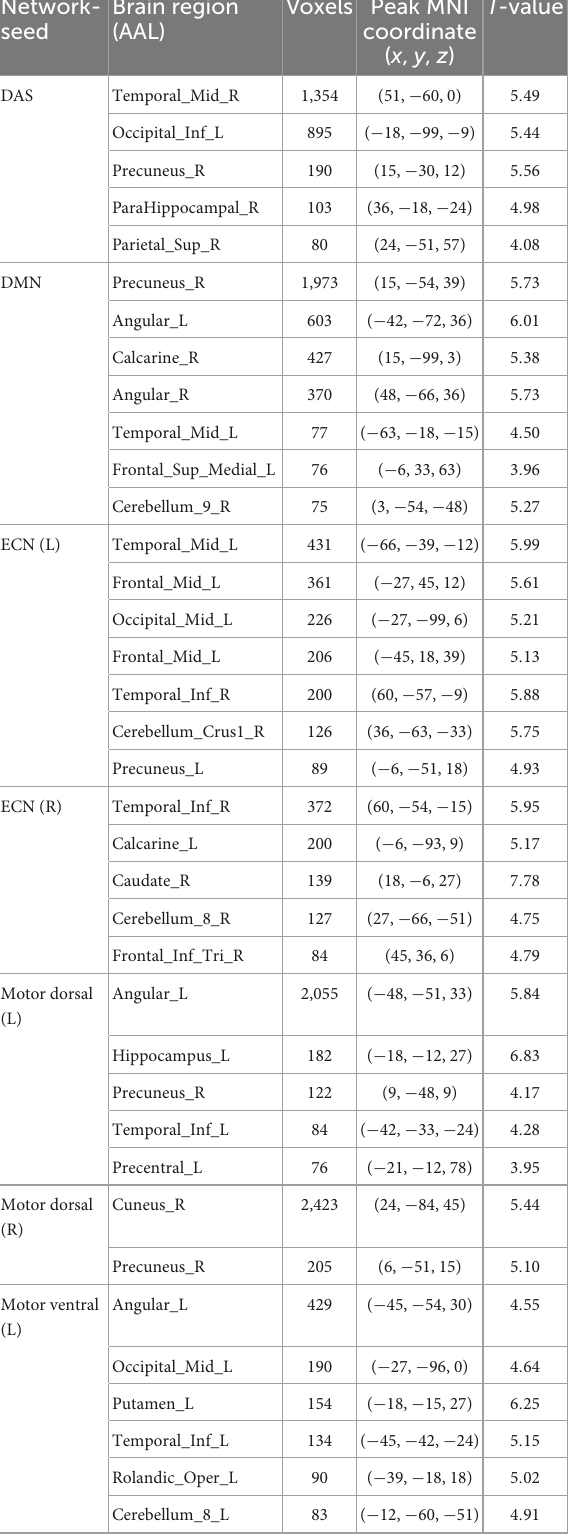
TABLE 4 Brain regions with significant network measure differences between the mTBI patients and HCs. Network-